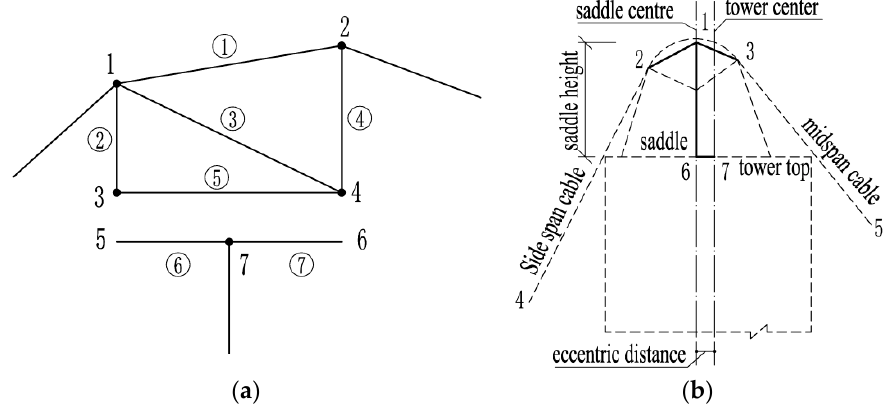
Figure 5. The saddle’s finite element simulation. ( a ) The saddle consists of five-rod elements. ( b ) Four beam elements simulate the saddle and pushing process.